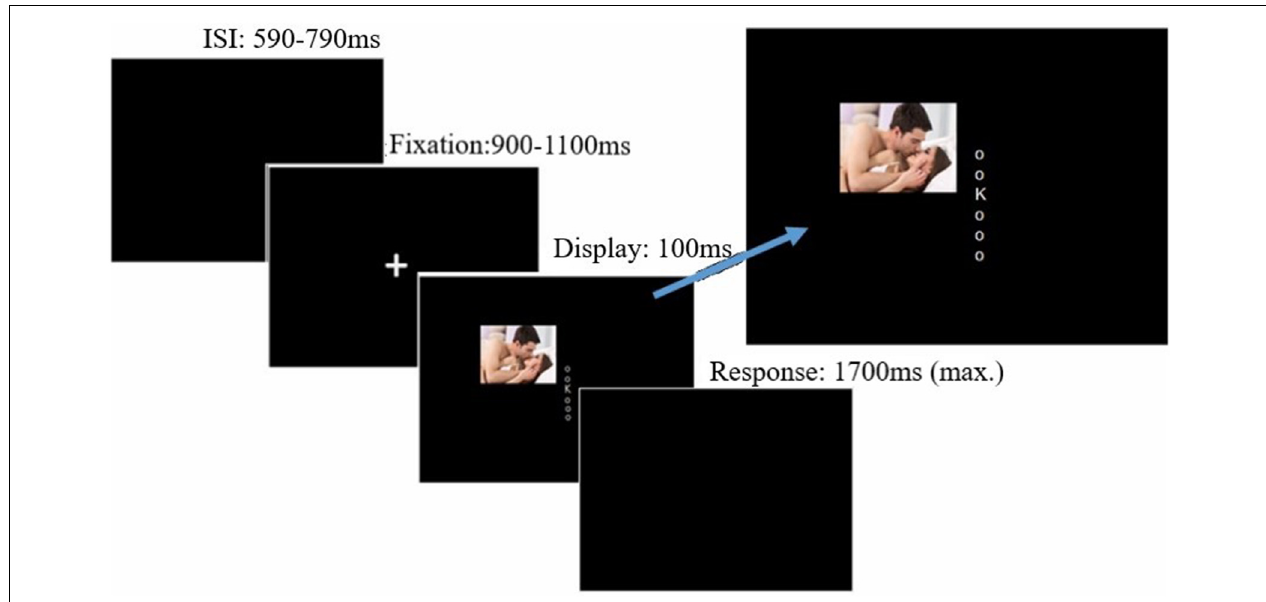
FIGURE 1 | Trial procedure and stimulus display. Distractors could appear lateral to the target display either in the upper or lower quadrant, blocked by hemi-field. Image for illustrative purposes only; the images were drawn from the International Affective Picture System (IAPS; Lang et al., 2008). Displays not to scale. Source: available from https://www.123rf.com/photo_29940472stock-photo.html, ©